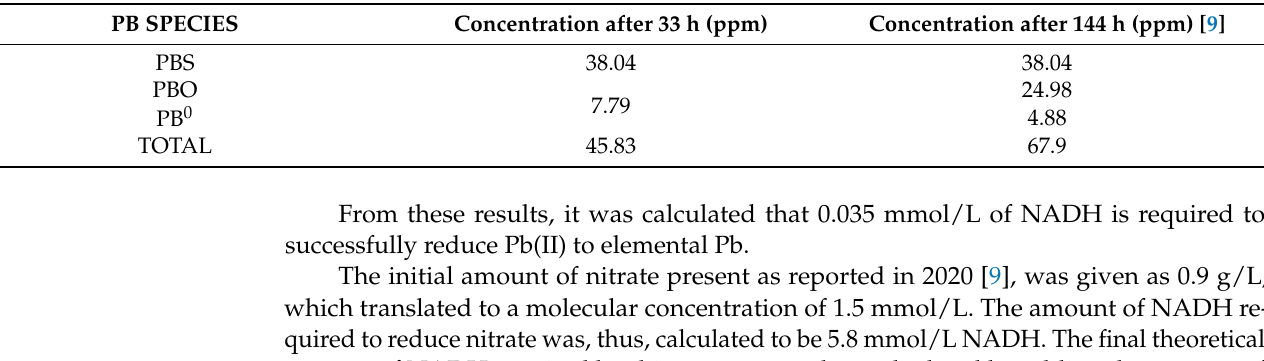
Table 5. Concentration of Pb species after 33 h and 6 days (144